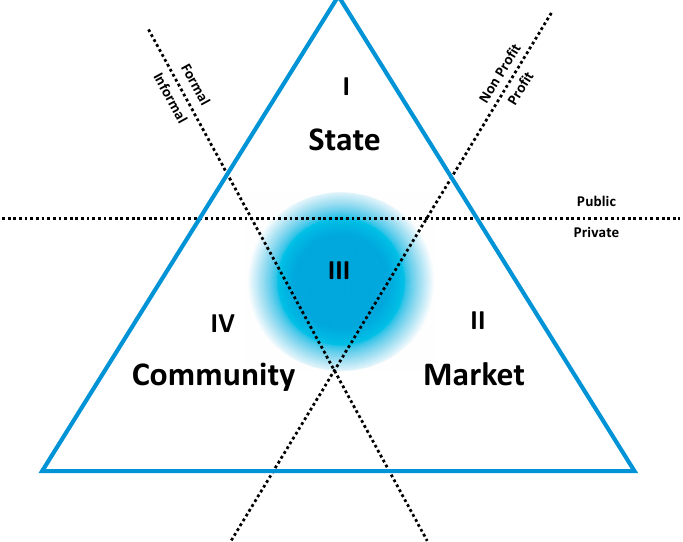
Figure 2. Classification of state, market, community and third-sector organizations. Sources: [47–49], adapted by [51] (p.